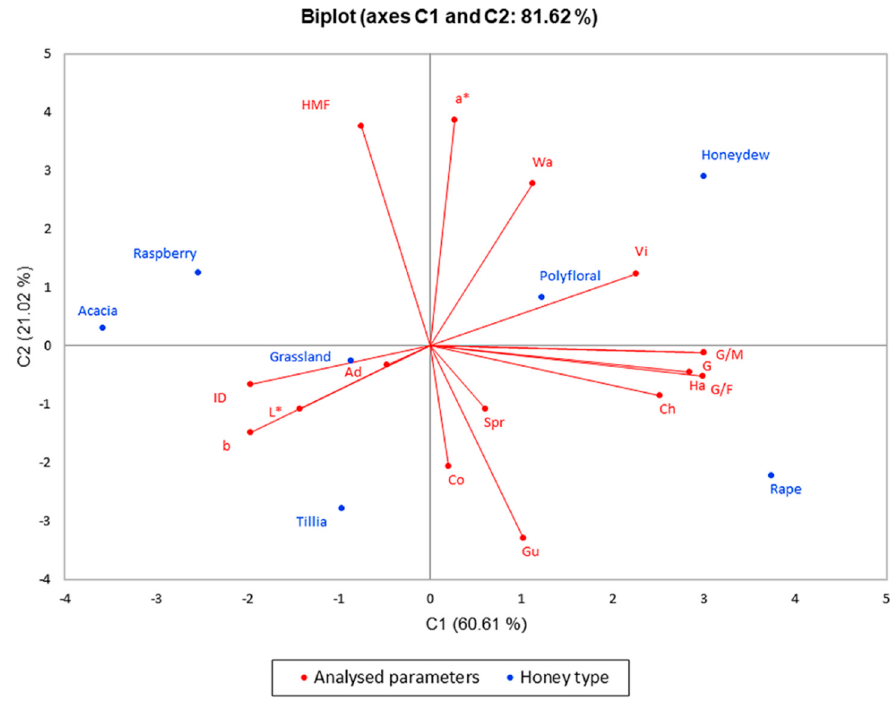
Figure 5. Principal component analysis regarding the honey types in the last month of